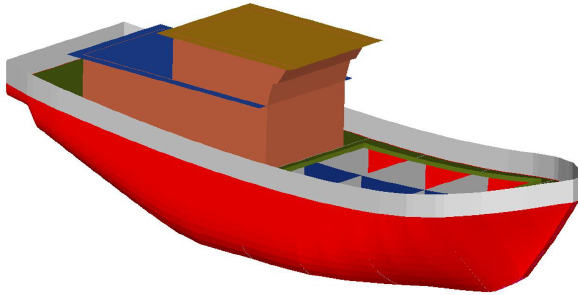
Figure 22: 3D geometry design of Batang type traditional purse seine hull